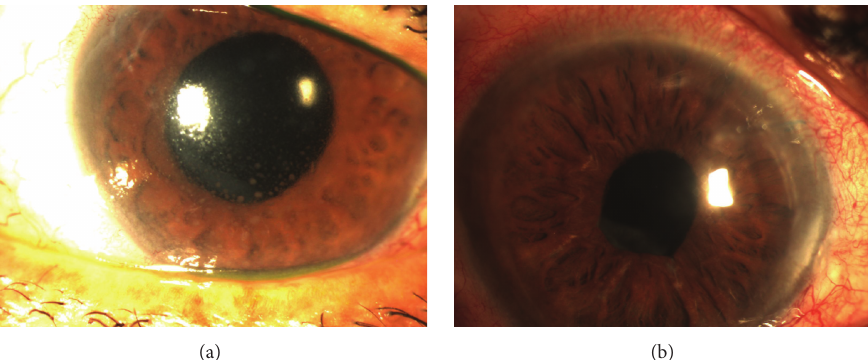
Figure 1: (a) Preoperative photo demonstrating corneal edema and keratic precipitates. (b) Postoperative photos demonstrating clear anterior chamber and cornea with stable DSEK graft and corneal stay suture.